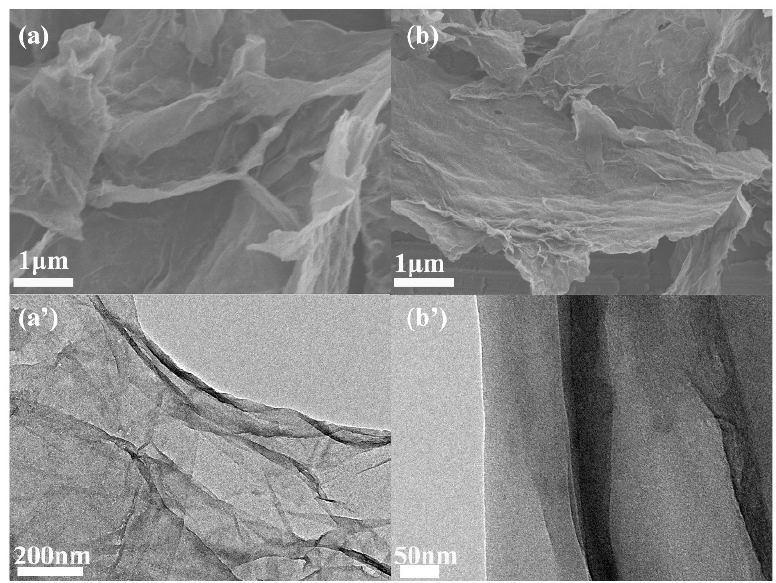
Figure 2. SEM images of GO ( a ) and PDA-rGO ( b ); TEM images GO ( a ′ ) and PDA-rGO ( b ′ ). Figure 3 shows the FTIR spectra of GO, rGO, and PDA-rGO. The C=O stretch- ing vibration peak at 1725 cm − 1 , the C-O stretching vibration peak of the hydroxyl group at 1056 cm − 1 , the C=C vibration peak of the aromatic ring at 1625 cm − 1 , and the stretching vibration peak of hydroxyl group O-H at 3420 cm − 1 are the characteris- tic peaks of GO [19,25,27]. The C=O stretching vibration peaks of rGO and PDA-rGO at 1725 cm − 1 decreased greatly, indicating that the carboxyl groups were mainly involved in the self-polymerization of dopamine onto the surface of GO. The newly generated peak at 1577 cm − 1 is attributed to the N-H vibrational of PDA-rGO. The peaks of 2926 cm − 1 and 2853 cm − 1 can be ascribed to the symmetric stretching vibration and asymmetric stretching vibration of -CH 2 in the molecular of PDA, respectively [22]. It can be confirmed that PDA was effectively coated onto the surface of GO through